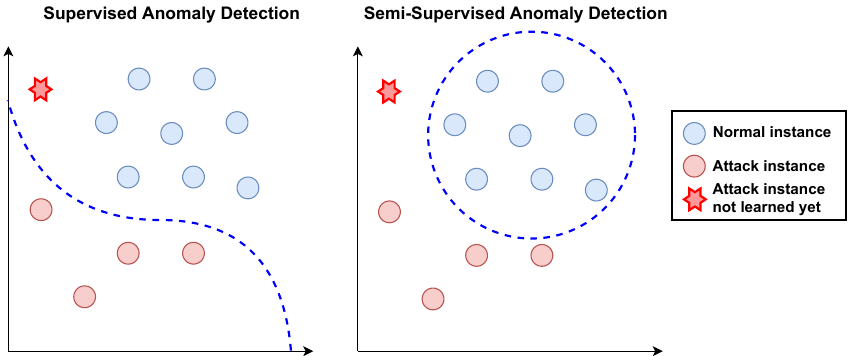
Figure 2. Supervised anomaly detection vs. semi-supervised anomaly